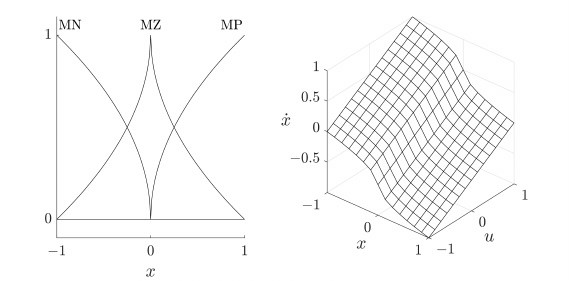
Figure 7. The dilation of the input membership functions x and the resultant inference map.